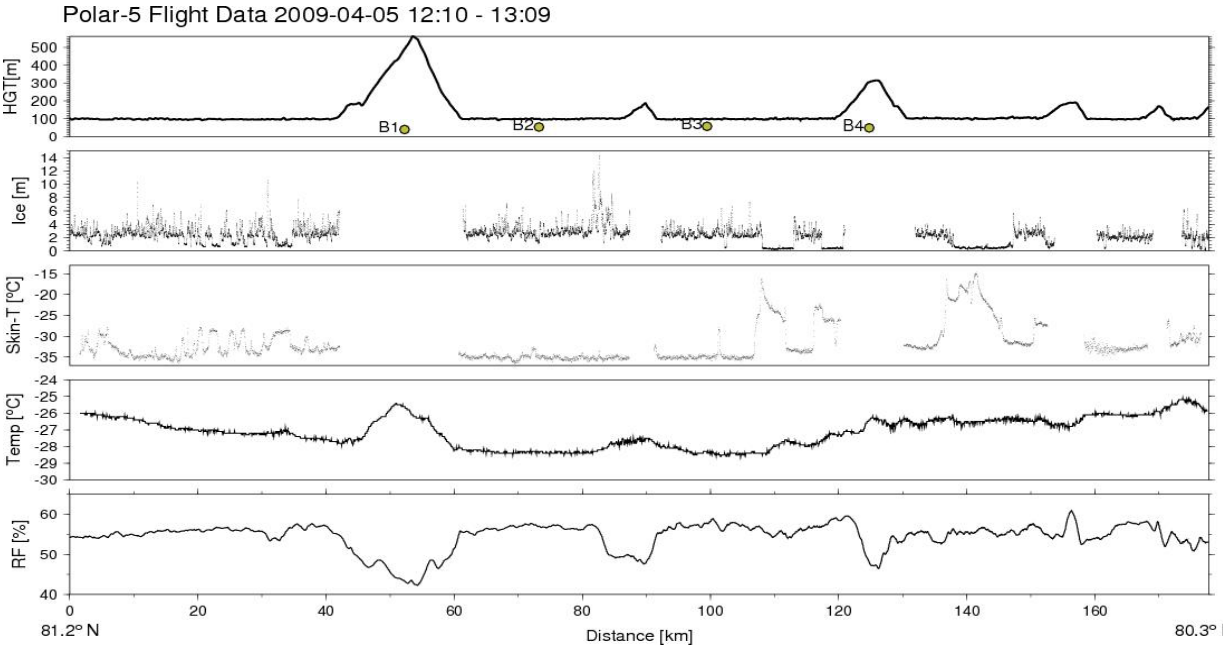
Figure 10. Data obtained during low-level flight segments of POLAR-5 on 5 ( a ), and 6 ( b ) April 2009. The x-axes indicate the distance from the first measurement and are oriented in north-south direction. The different panels indicate time series of the altitude (GPS signal), ice thickness, skin temperature, air temperature and relative humidity. The numbers in the uppermost panels indicate the location of the dropsondes launched on the outbound leg at higher altitudes. Wind data are not available. Panel ( c ) and ( d ) show aircraft data of altitude (GPS signal), Condensation Nucleus (CN) concentration, air temperature and relative humidity obtained on two flight legs on 10 April 2009, the flight to the NP-36 ( c ) at 2,000 m altitude (free atmosphere) and the flight to Alert in the boundary layer ( d